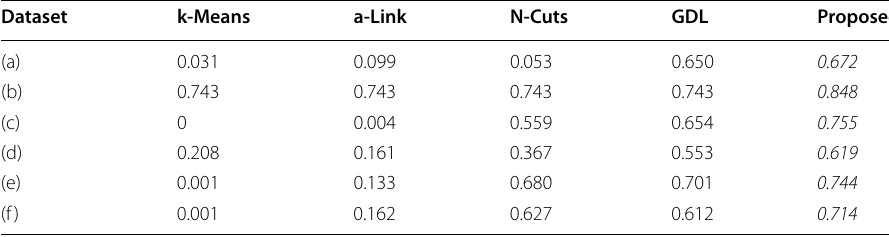
Italics indicates the best score of each experiment